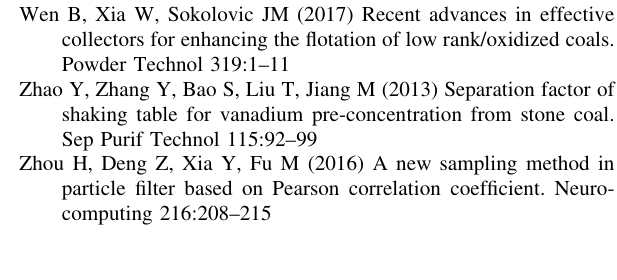
shaking table for vanadium pre-concentration from stone coal. Sep Purif Technol